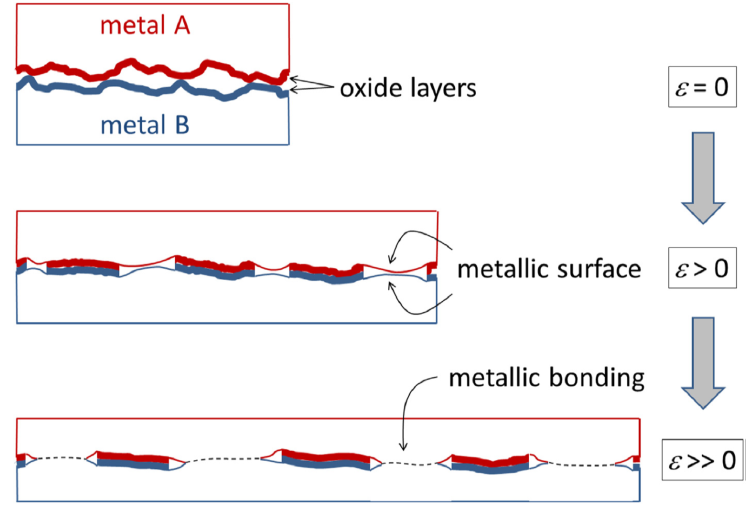
Figure 5. Schematic of interfacial plastic deformation resulting in cold welding. Under high strain, there is contact between fresh metallic surfaces, grain boundaries form between the metals [28]. Copyright 2016 Elsevier.